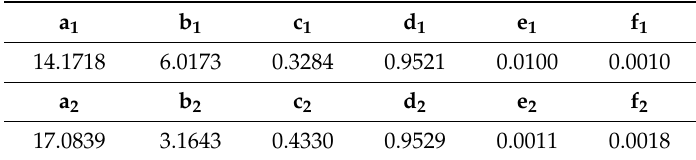
Figure 5. ( a ) Brightness temperatures of 6H and 10H: group A for calm ocean conditions and group B for rough ocean conditions; ( b ) Thematic figure drawn from ( a ). The two figures can be found in [15]. Table 2. Model coefficients in Equations (10) to (17).